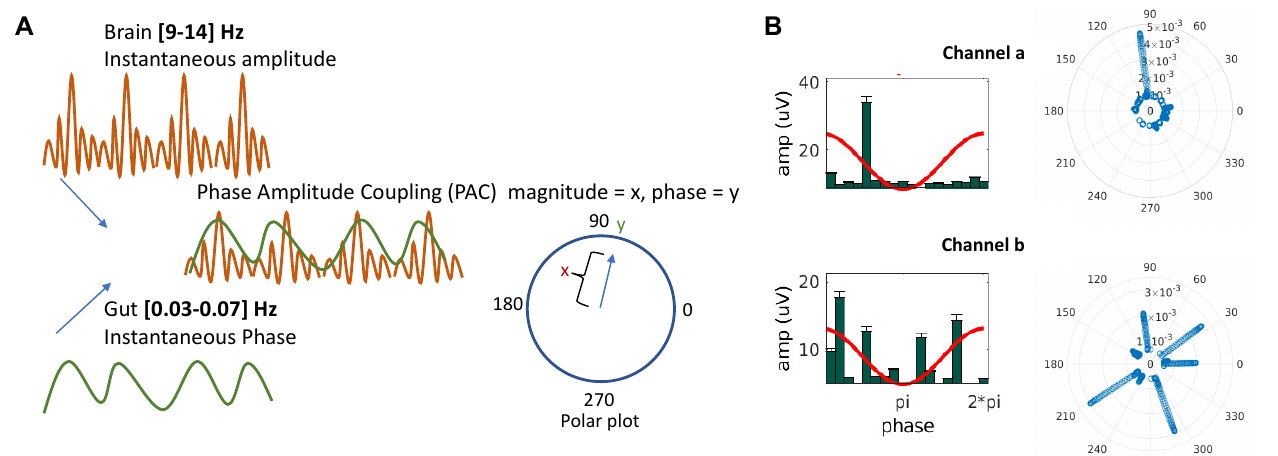
Figure 2. Phase Amplitude Coupling (PAC). ( A ) Illustration for computing PAC with instantaneous amplitude of the fast frequency EEG signal and instantaneous phase of the slow frequency EGG signal, and polar plot representation of the resultant coupling mean vector magnitude (x) at phase (y) ( B ) Illustrative examples of high coupling at phase ~100 degrees (top), and dispersed coupling spread over various phases (bottom).